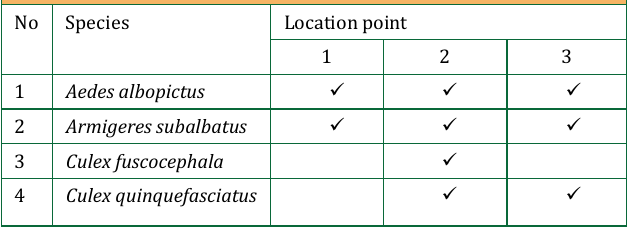
Table 1: Types of Mosquitoes (Culicidae) caught in Kahyapu Village, Enggano District, North Bengkulu Regency